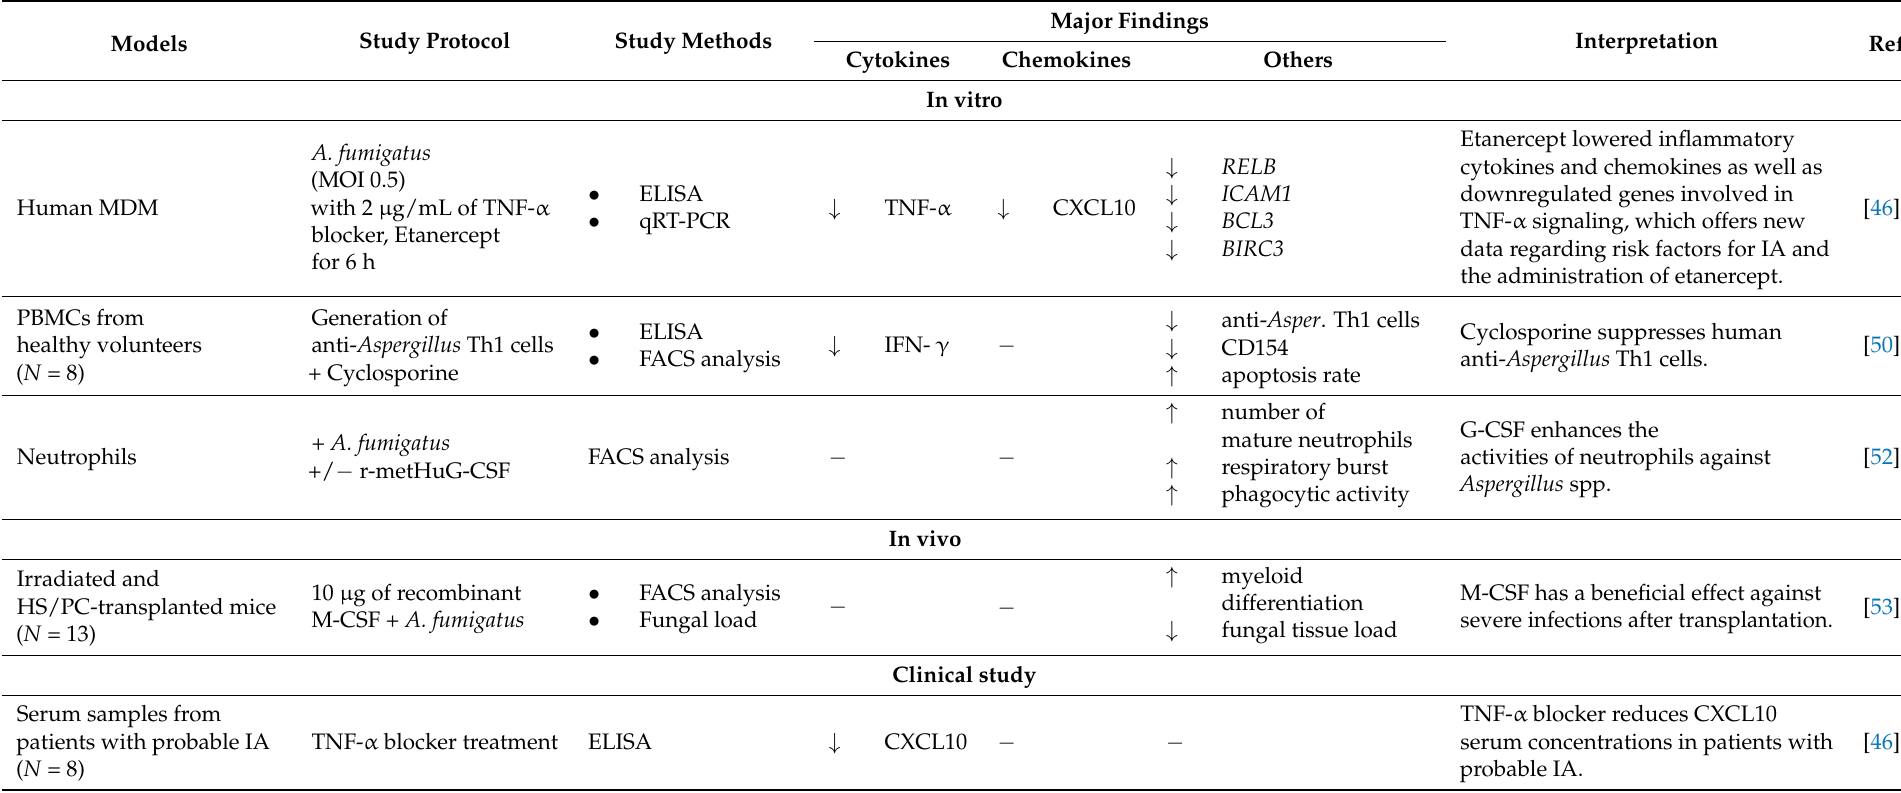
Table 3. Drug-related cytokine alterations associated with invasive aspergillosis in hematopoietic stem cell transplantation